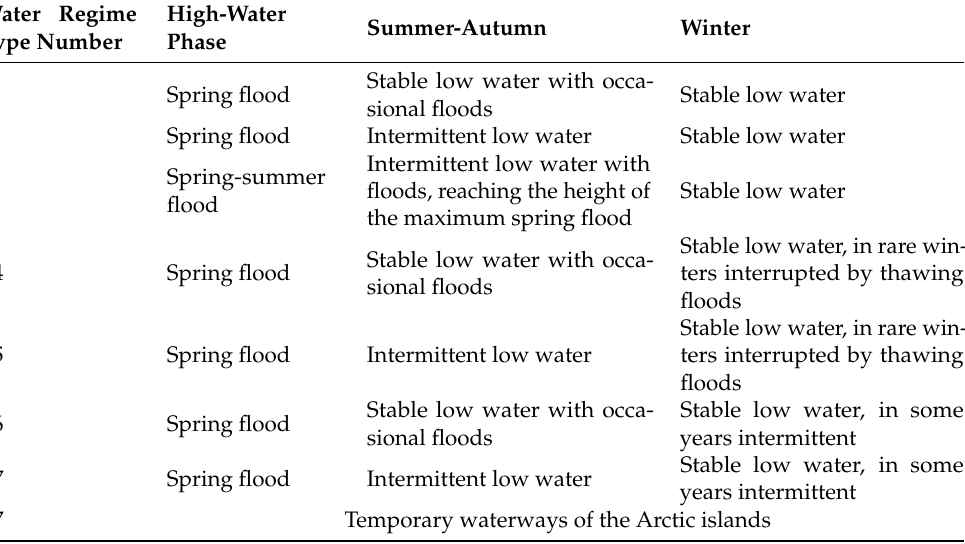
Figure 1. Digitized map of water regime types. A detailed description of the legend is provided in Table 1. Table 1. The definition of derived water regime types for the territory of northwest Russia (based on Evstigneev et al.